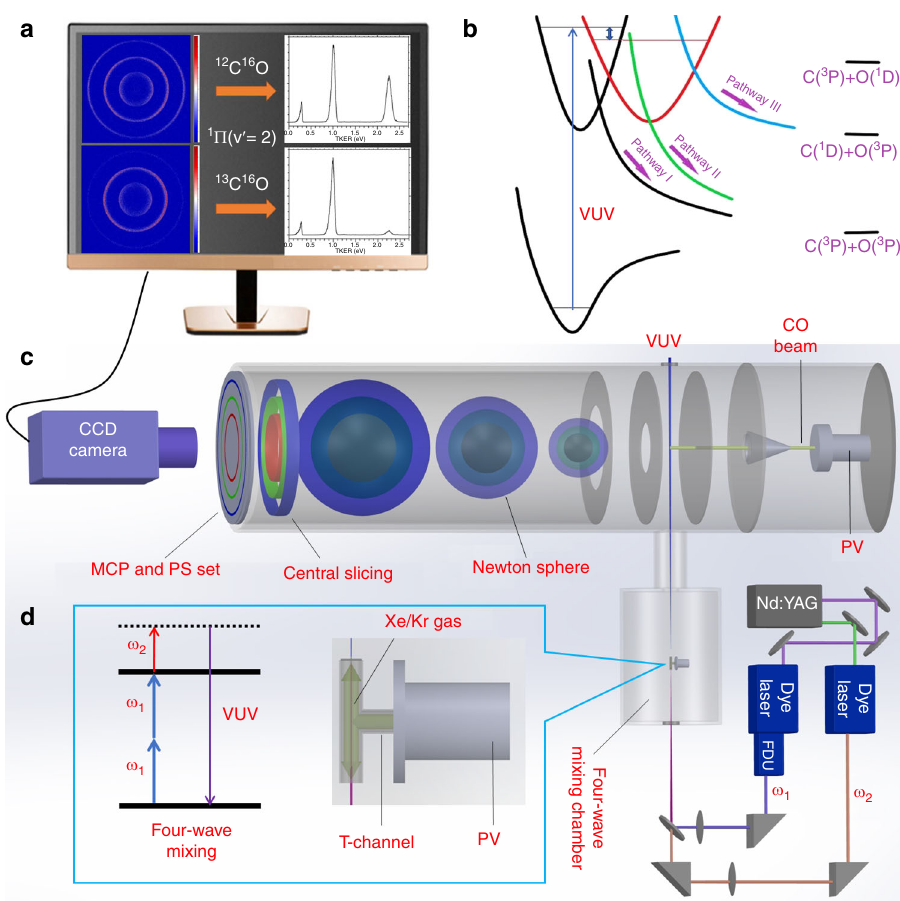
Fig. 1 Schematic diagram of the experimental setup. a Raw time-slice velocity map imaging (TSVMI) images and the corresponding total kinetic energy release (TKER) spectra for 12 C 16 O and 13 C 16 O in the absorption band with upper state of 1 Π (v ′ = 2). b Three possible dissociation pathways of CO following the absorption of a single VUV photon: Pathways I and II go to C( 3 P) + O( 3 P), Pathway III goes to C( 1 D) + O( 3 P) (see text for details). c Time-slice velocity-map ion imaging system. d Tunable VUV laser radiation source generated by the two-photon resonance-enhanced four-wave mixing scheme using a Xe or Kr gas jet as the nonlinear medium. MCP micro-channel plate; PS phosphorscreen; VUV vacuum ultraviolet; PV pulsed valve; FDU frequency doubling